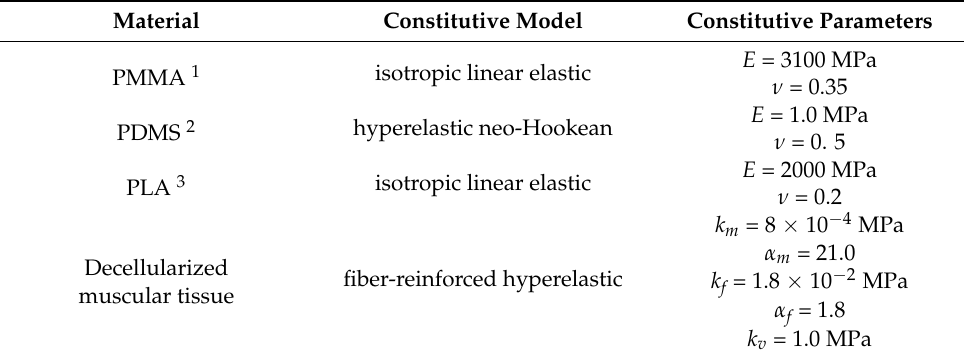
Table 2. Constitutive models and parameters for the different